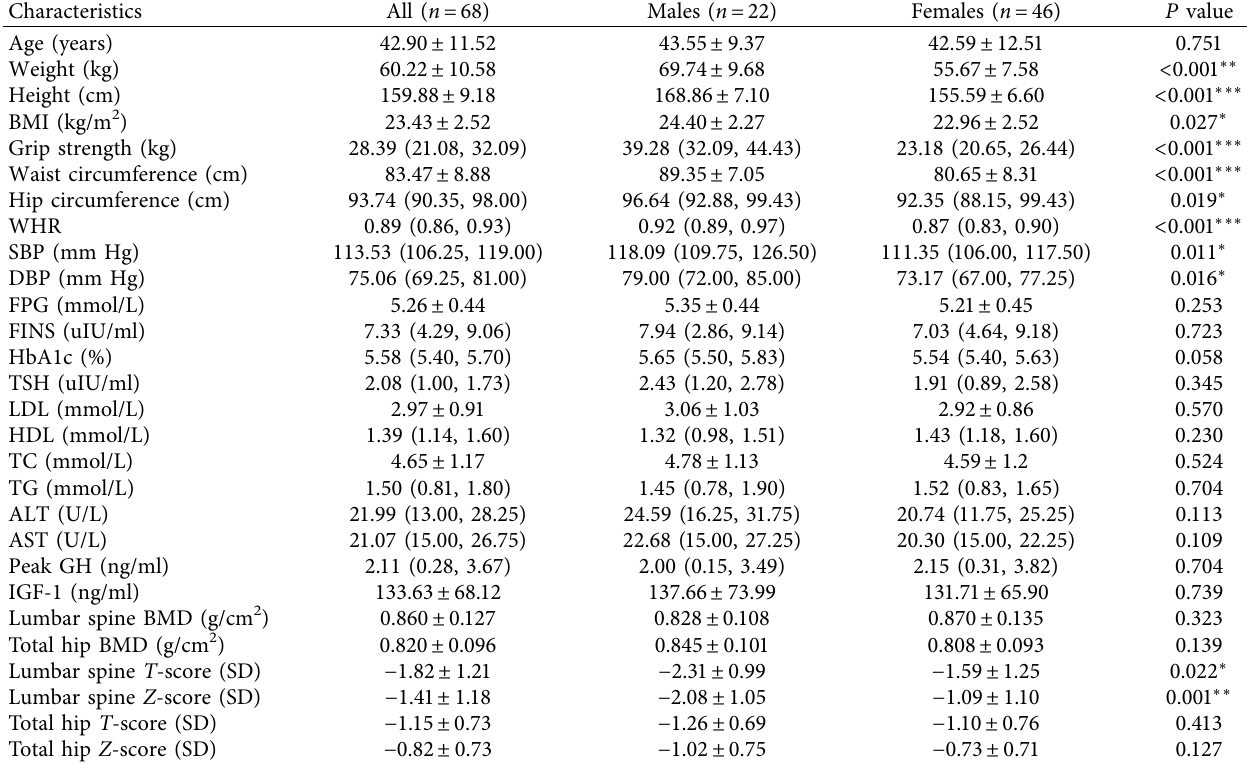
Table 1: Baseline characteristics of all AGHD patients.